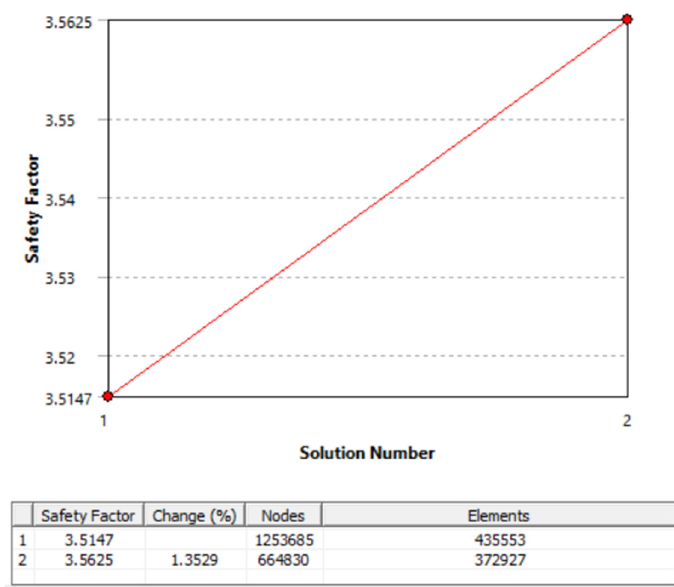
Figure 6. Convergence